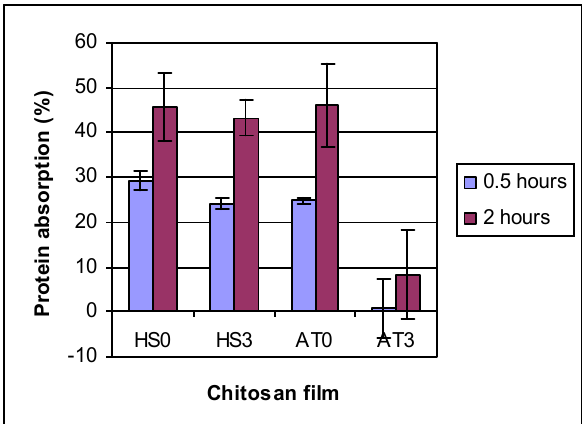
Figure 5. The protein absorption on chitosan films. 2 Factor ANOVA showed differences due to chitosan type and time. AT3 and control were different from all others, but were not different from each other. 2 h also differs from 0.5